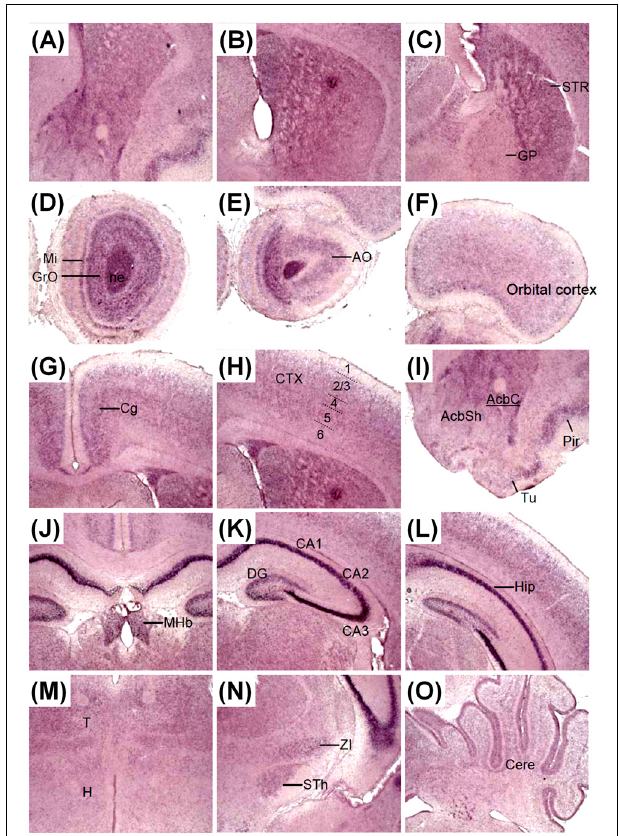
FIGURE 7 | Zswim6 mRNA expression pattern in P7 mouse forebrain. Zswim6 mRNA signals were detected from rostral to caudal levels at P7 ( A–C ). Moderate to strong Zswim6 signals were expressed in the olfactory bulb ( D,E ), dorsal and ventral striatum (A–C, I) , cortex (F–I) , hippocampus (J–L) , thalamus (M,N) , cerebellum (O) , and medial habenular nucleus (J) . AcbC, nucleus accumbens, core; AcbSh, nucleus accumbens, shell; AO, anterior olfactory nucleus; Cere, cerebellum; Cg, cingulate cortex; CP, cortical plate; CTX, cortex; DG, dentate gyrus; GP, globus pallidus; GrO, granular cell layer of the olfactory bulb; H, hypothalamus; Hip, hippocampus; MHb, medial habenular nucleus; Mi, mitral cell layer of the olfactory bulb; OB, olfactory bulb; Pir, piriform cortex; T, thalamus; Tu, olfactory tubercle; STh, subthalamic nucleus; STR, striatum; ZI, zona incerta.